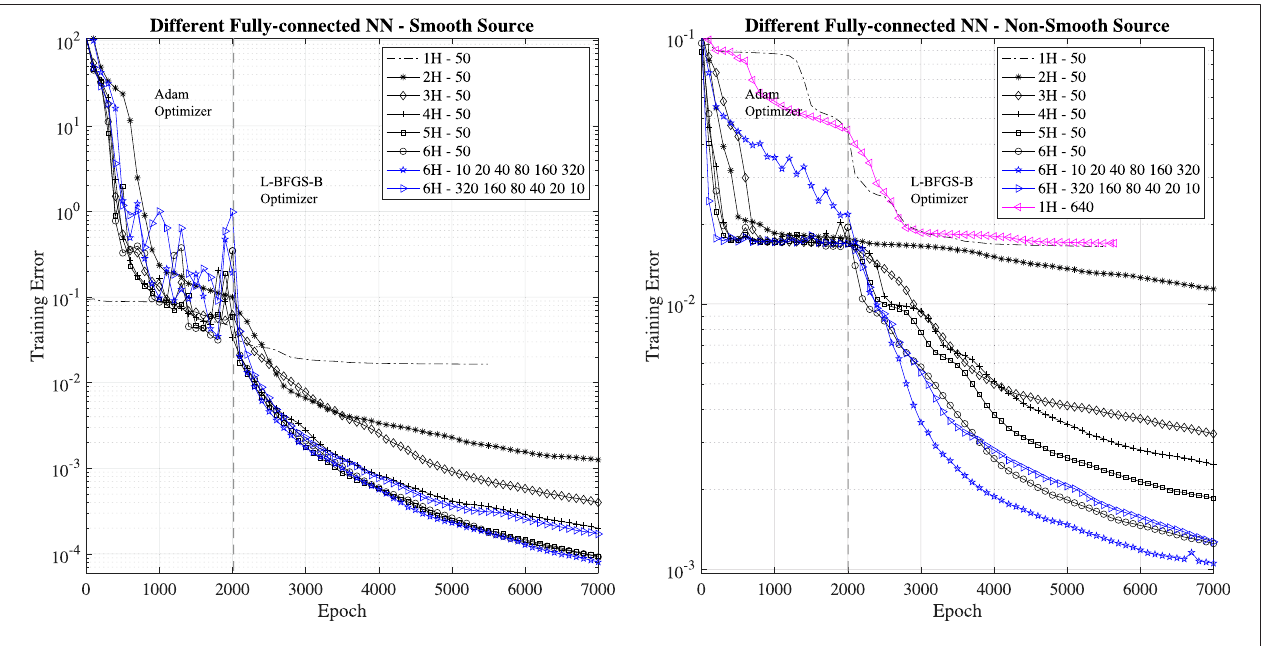
FIGURE 3 | Training error for different fully-connected PINN depth: one (1H), two (2H), three (3H), four (4H), fi ve (5H) and six (6H) hidden layers with 50 neurons each. We also consider the training error for PINNs with six hidden layers and 10-20-40-80-160-320 and 320-160-80-40-20 – 10 units per hidden layer, respectively.